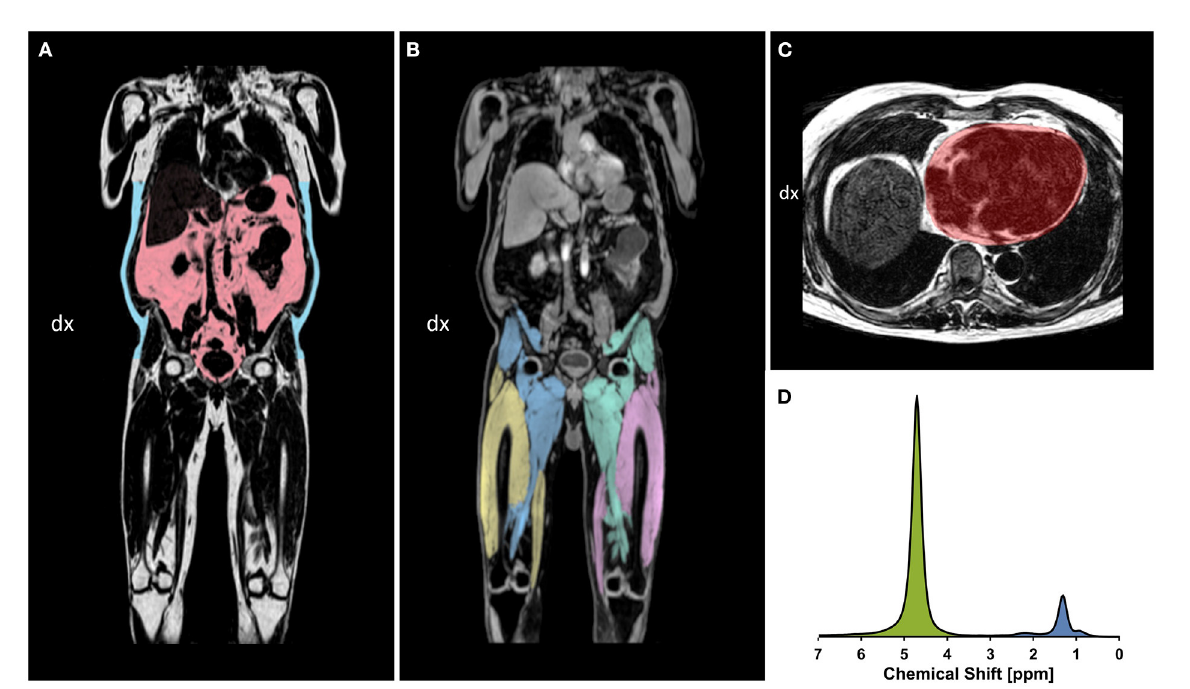
FIGURE1 (A,B) example coronal slices of whole-body Dixon images. (A) Fat images with the VAT (red) and ASAT segmented (blue). (B) Water images with the segmented thigh muscle groups: right posterior thigh (blue), right anterior thigh (yellow), left posterior thigh (green), and left anterior thigh (pink). (C) Cardiac fat image in transversal view from the 3D Dixon sequence, showing the segmented region of interest (red) following the epicardial border. (D) Liver H-1 MR spectrum obtained at 1.5T, showing the water resonance at 4.76 ppm (green), and the major fatty-acyl chain resonances at 1.21 ppm (methylene), as well as 0.9 ppm (methyl) and 2.2 ppm (alpha-olefinic etc) (blue). All lipid resonances were included in the integration